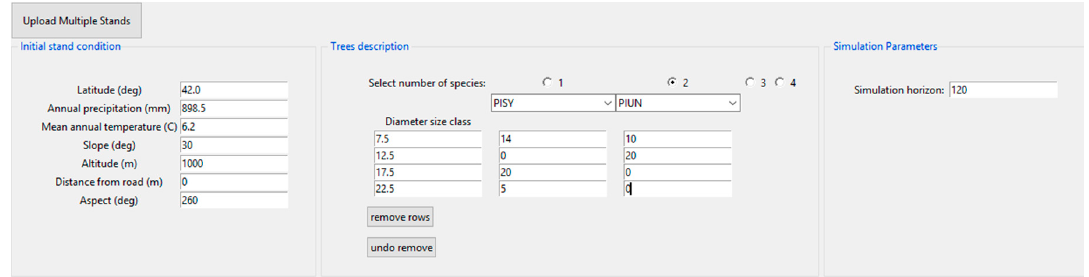
Figure 4. Input data UI. Initial stand condition is defined in terms of plot parameters (latitude, annual precipitation, annual mean temperature, etc.) and tree